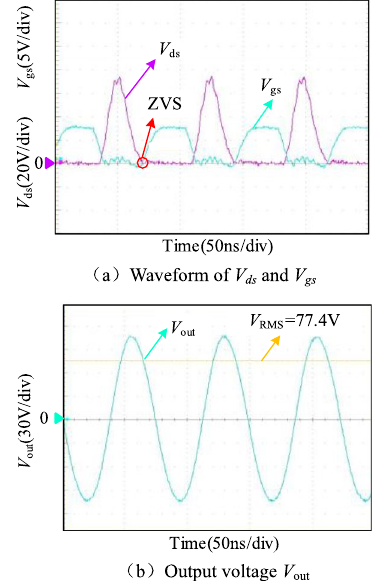
Fig. 11 Working waveforms under full power operation. a Waveform of V ds and V gs b Output voltage V